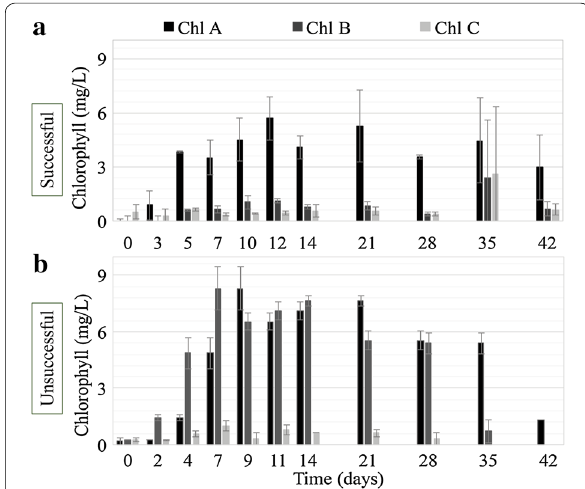
Fig. 6 Log 2 fold change of the target genes CYAN , amoA, and narG using 16S rDNA as a reference and compared to the t values were >0.98 for all calibrations. qPCR reaction efficiencies were greater than 90%. Significant interaction effects were further determined with Tukey’s HSD test if the ANOVA results were significant (p < 0.05)—*p < 0.05, **p < 0.01, ***p <